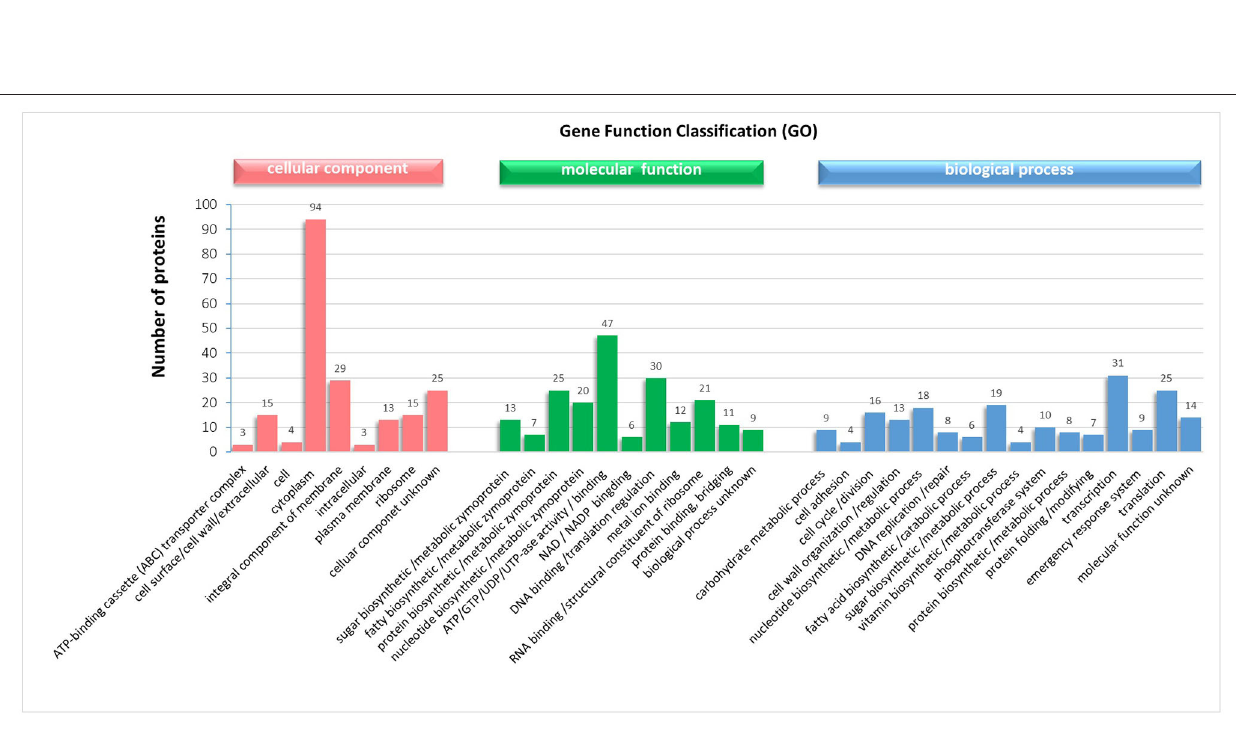
Frontiers in Microbiology |